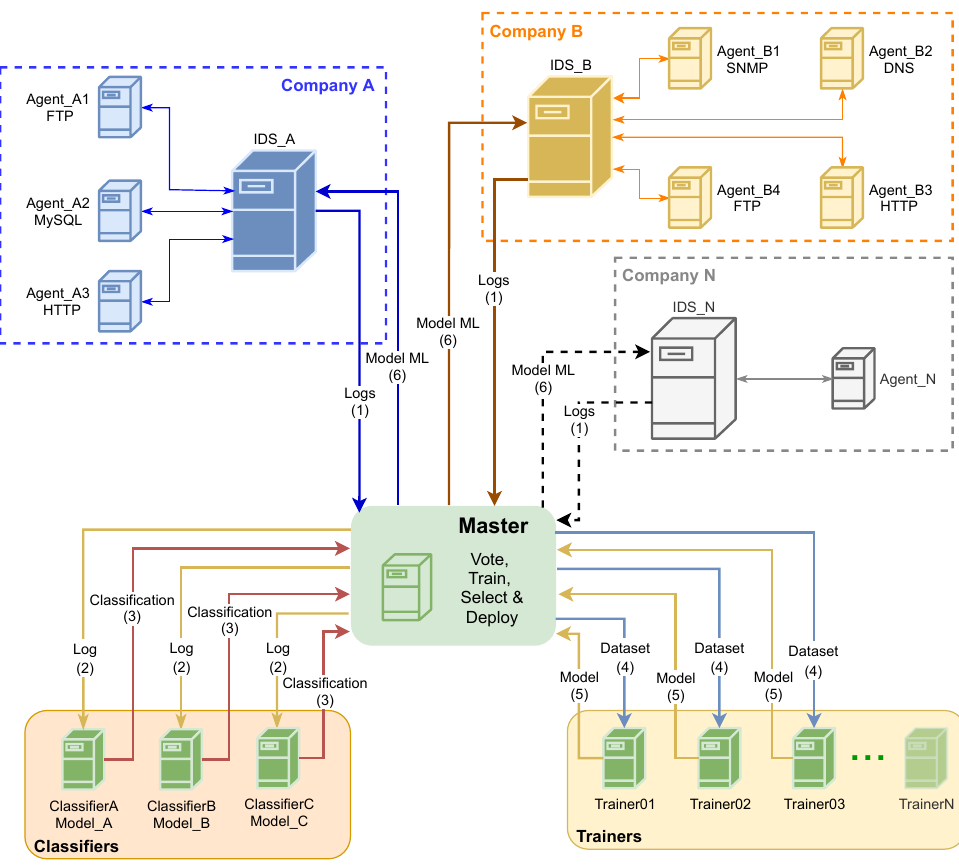
Figure 2. General